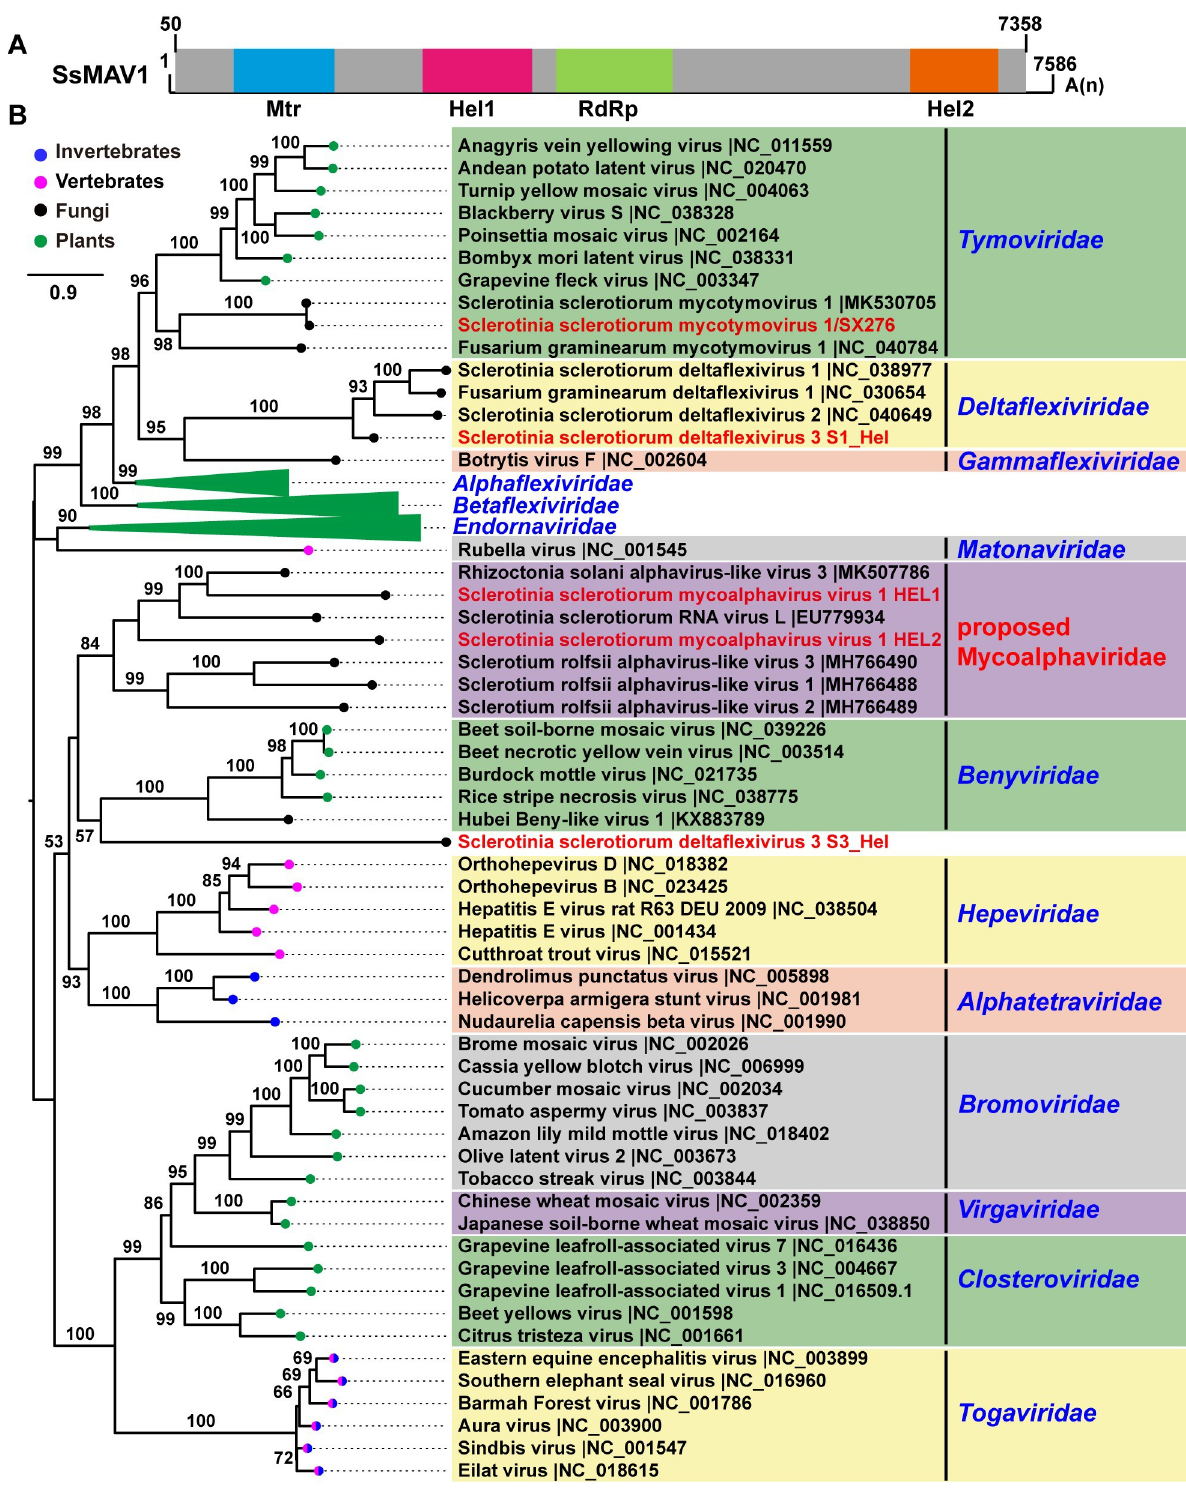
Fig 3. Genome organization of SsMAV1 and phylogenetic tree of SsMAV1 and SsDFV3 based on helicase sequence. (A) The genome organizations of SsMAV1. Open reading frames (ORFs) are shown as boxes. (B) A maximum likelihood phylogenetic tree was constructed based on amino acid alignments of helicase. The viruses in different families belong to alpha-virus subgroup were selected. Bootstrap values (%) obtained with 1000 replicates are indicated on the branches, and branch lengths correspond to genetic distance; the scale bar at the lower left corresponds to genetic distance. The viruses SsMAV1 and SsDFV3 are highlighted with red font. https://doi.org/10.1371/journal.ppat.1009823.g003 PLOS Pathogens| https://doi.org/10.1371/journal.ppat.1009823 August 24,